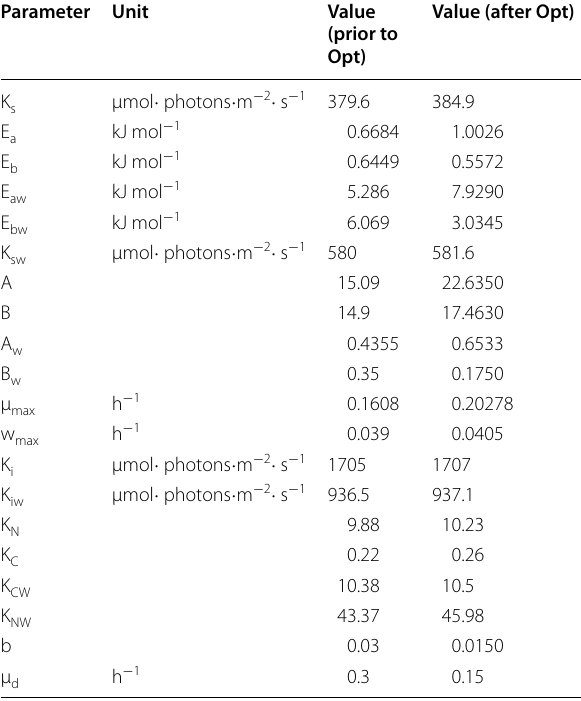
Table 2 Optimization of model parameters (optimized by MATLAB)